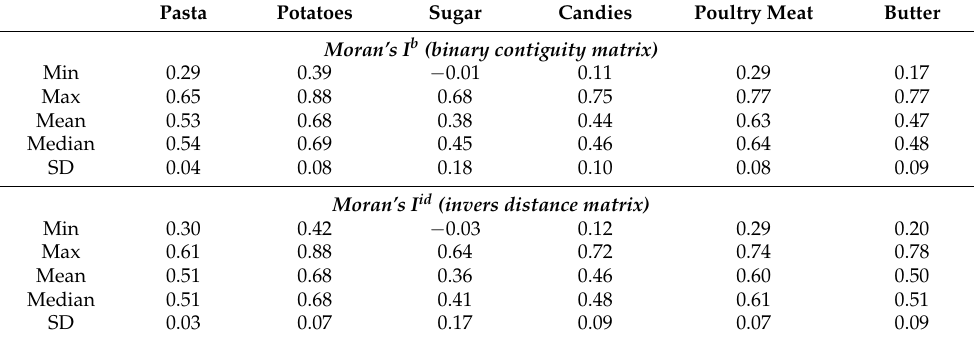
Table 3. Global Moran’s I.